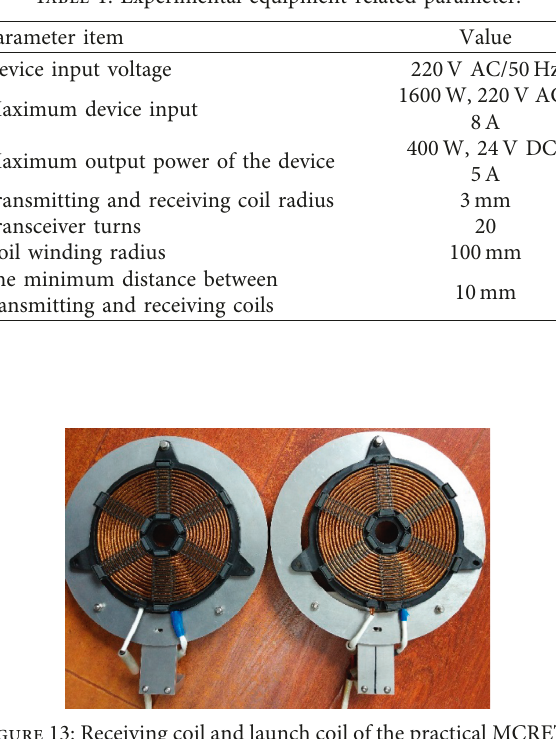
Table 1: Experimental equipment-related parameter.